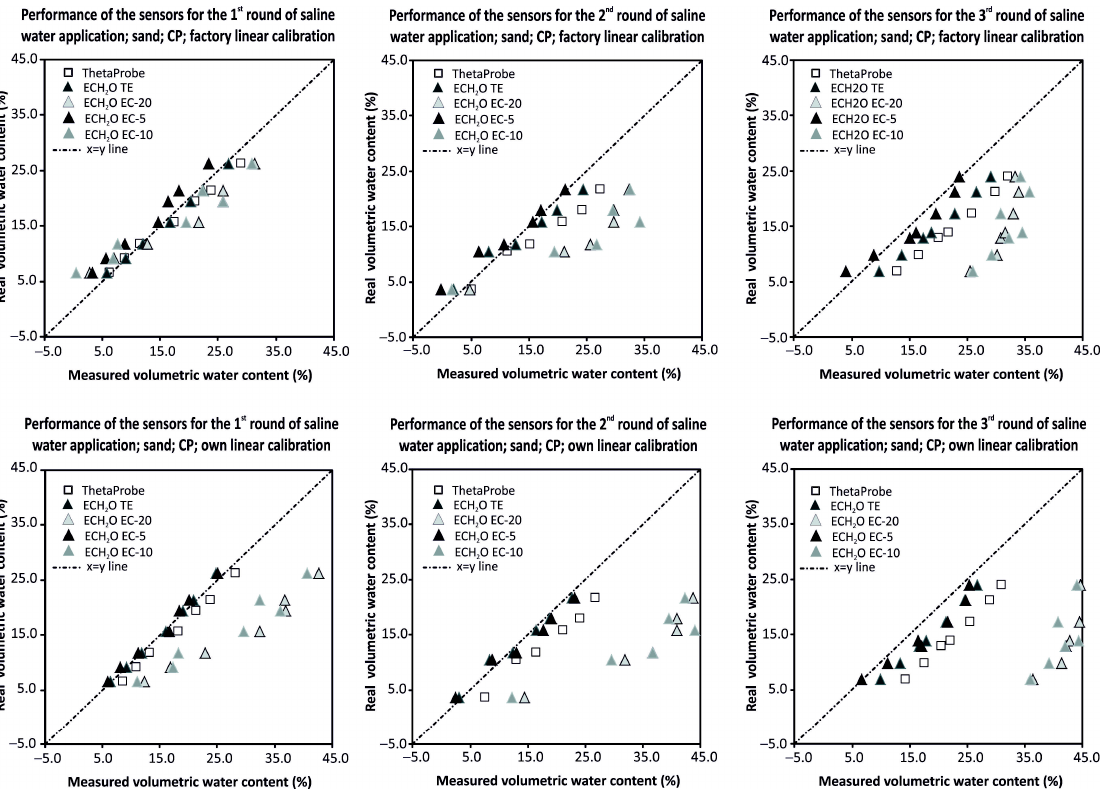
Figure 5. Performance of all tested sensors for three rounds of saline water applications for a sand media and compact packing using factory and our own linear calibration equations.